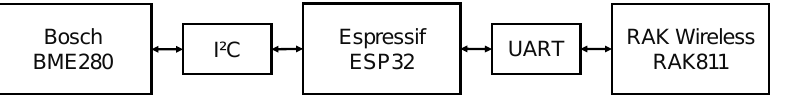
Figure 2. Block diagram showing the components and interfaces of the beehive microclimate sensor.